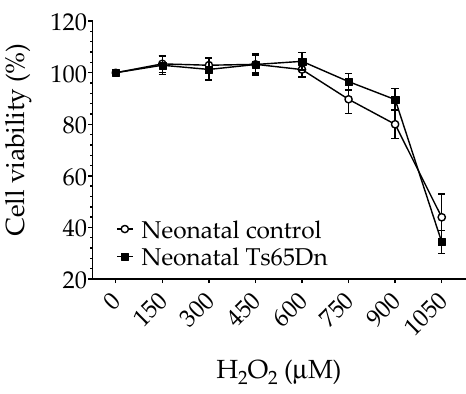
Figure 5. Cytotoxicity of hydrogen peroxide in neonatal control and Ts65Dn astrocytes measured by MTT reduction expressed as a percentage of untreated control cells. Cultures were exposed to the indicated concentrations of hydrogen peroxide added to the culture media for 24 h. Data are the means ± SEM, n = 6–12/group performed in triplicate.